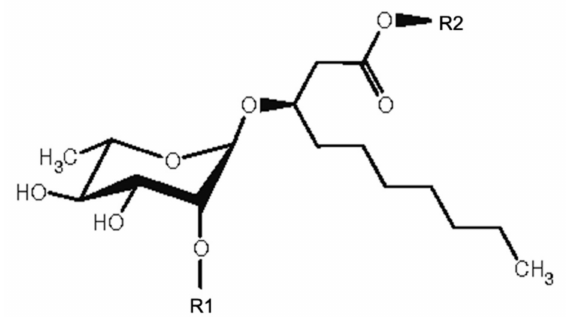
Figure 2. The rhamnolipid structure with all possible chemical modifications indicated. R1—position where the second rhamnose molecule can be attached and, thus, di-rhamnolipid is formed. R2—fatty acid of various lengths (Adapted from